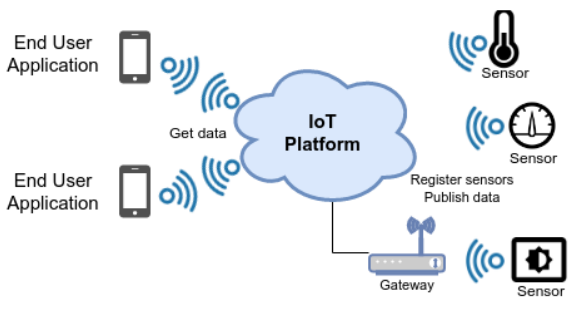
Figure 1. General Internet of Things (IoT)